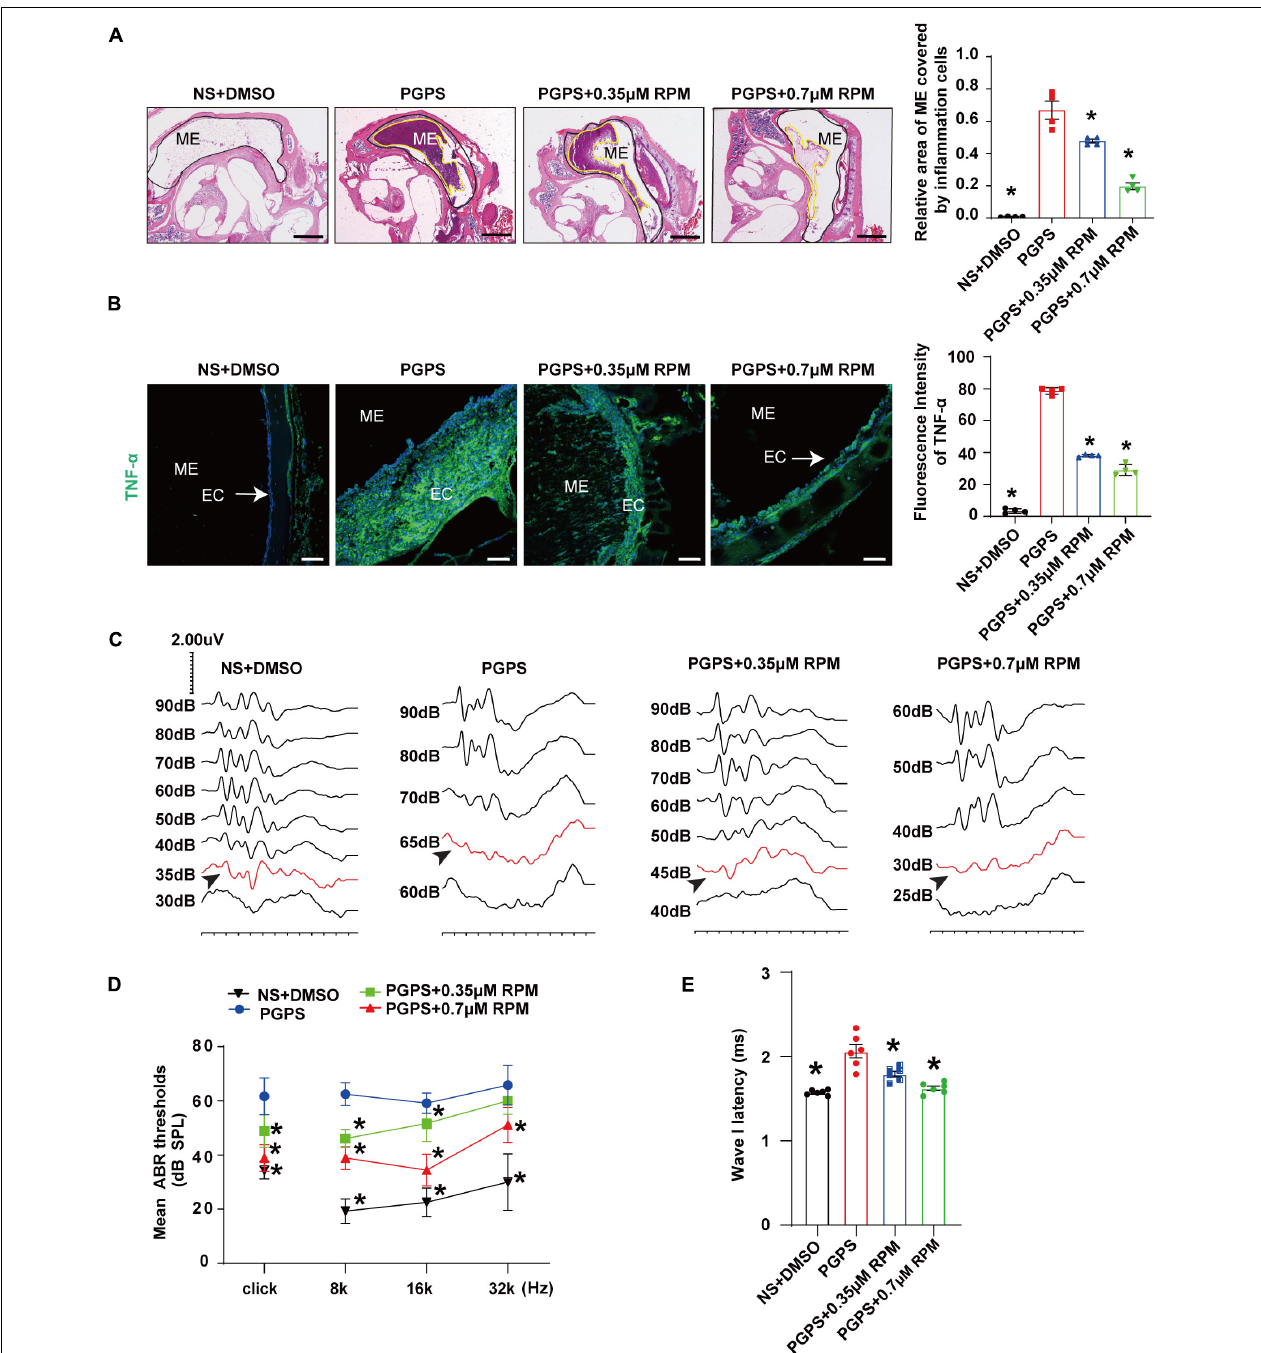
FIGURE 2 | Rapamycin treatment inhibits PGPS-induced inflammation and improves hearing function in PGPS-inoculated OM mice. (A) H&E histological images showing the structures and pathology of the ME. Quantification of the relative area of ME covered by inflammatory cells is shown in the bar graph. n = 4 per group. (B) Representative immunostaining for TNF- α expression in the ME. Quantification of the fluorescence intensity of TNF- α is shown in the bar graph. n = 4 per group. (C) Representative images of ABR waveforms at click stimuli are shown. The red lines and arrowheads represent threshold waveforms. (D) Mice were inoculated with PGPS or a combination of PGPS and either 0.35 or 0.7 µ M RPM. The ABR thresholds were measured at the stimuli frequencies of click, 8, 16, and 32 kHz. The mean ABR thresholds in the NS + DMSO, PGPS + 0.35 µ M RPM, and PGPS + 0.7 µ M RPM groups were compared with those in the PGPS group. The data is presented as the mean ± SEM. n = 10 per group. (E) The latency of ABR wave I at click stimuli (80 dB SPL) in the NS + DMSO, PGPS + RPM combination treatment groups were compared with that in the PGPS group. Horizontal bars are mean values. n = 10 per group. * P < 0.05 vs. the PGPS group, one-way ANOVA, Scale bar, 100 µ m (A) , 50 µ m (B)